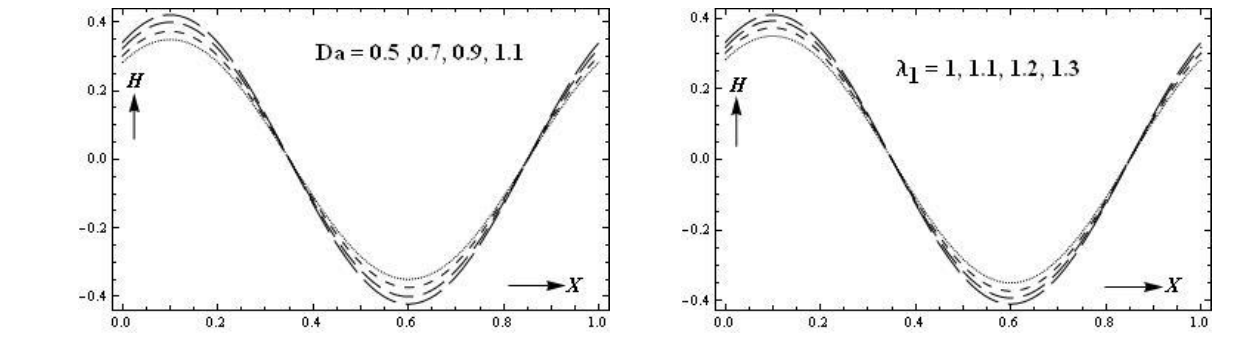
Figure 11 . Heat transfer coefficient for various values of Jeffrey parameter.